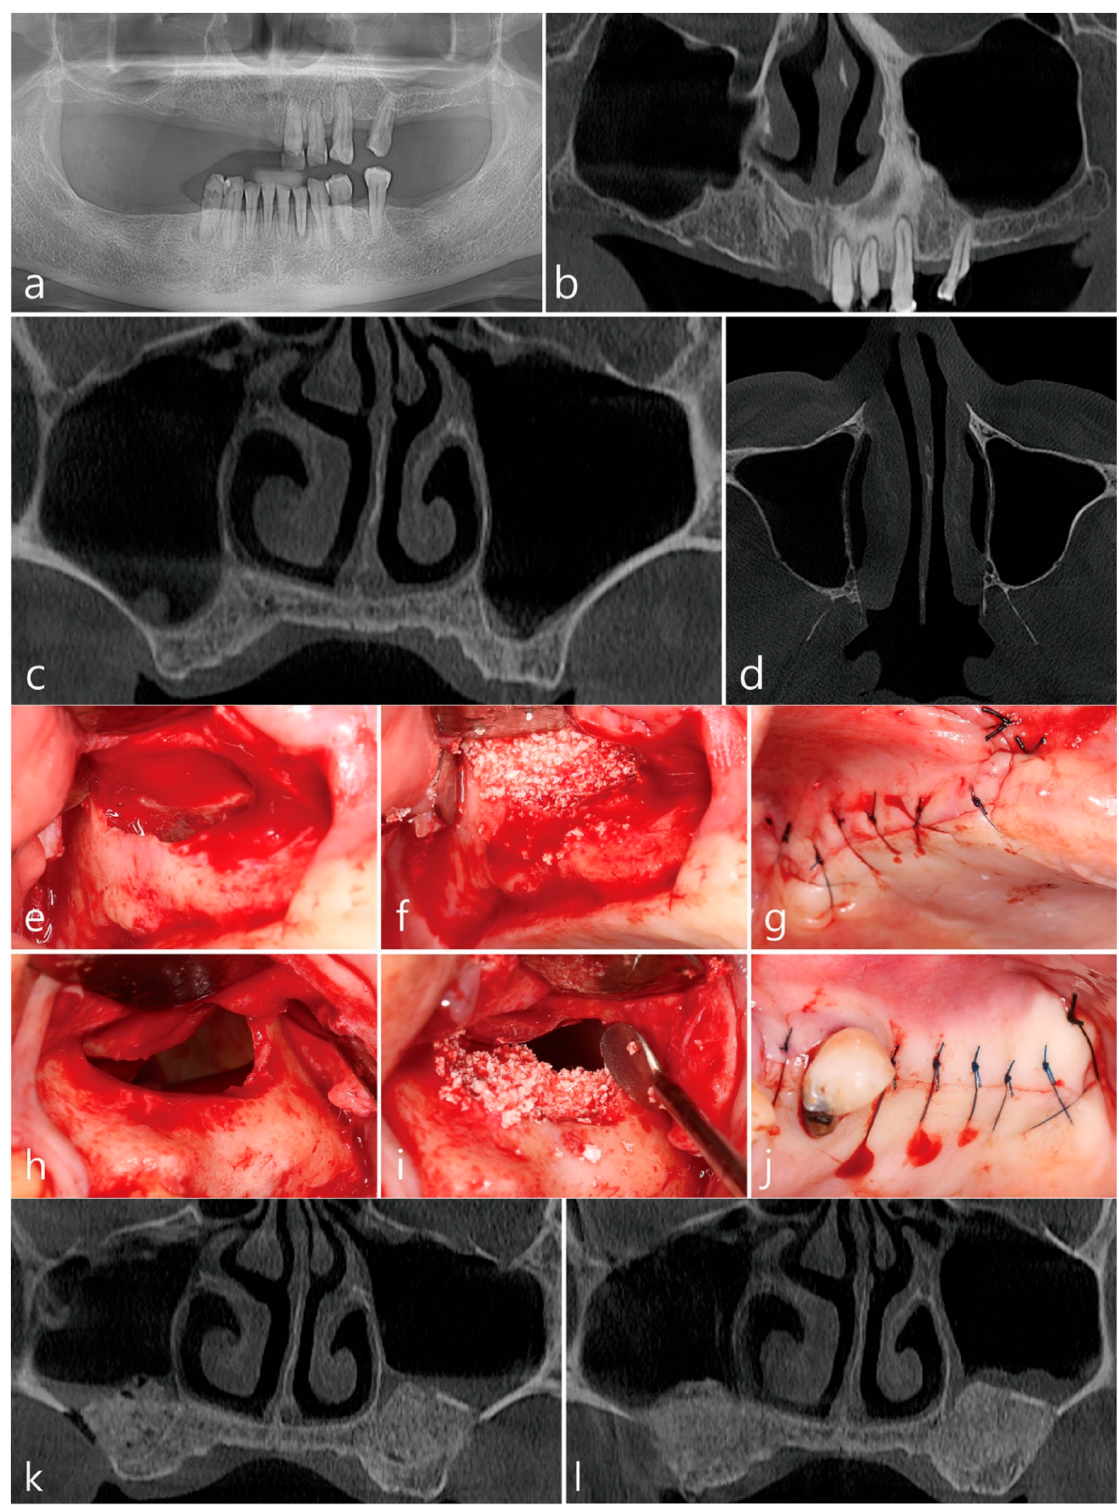
Figure 3. Case 3. ( a ) Preoperative panoramic radiograph. The right maxillary sinus was pneumatized and the residual alveolar bone was extremely insufficient. On the other hand, the left maxillary sinus was pneumatized, but some amount of residual alveolar bone was present; ( b ) Panoramic radiograph of preoperative CBCT scan. There was slight membrane thickening on the sinus floor, but the overall maxillary sinus was healthy; ( c ) Coronal image of preoperative CBCT scan. No blood vessels were